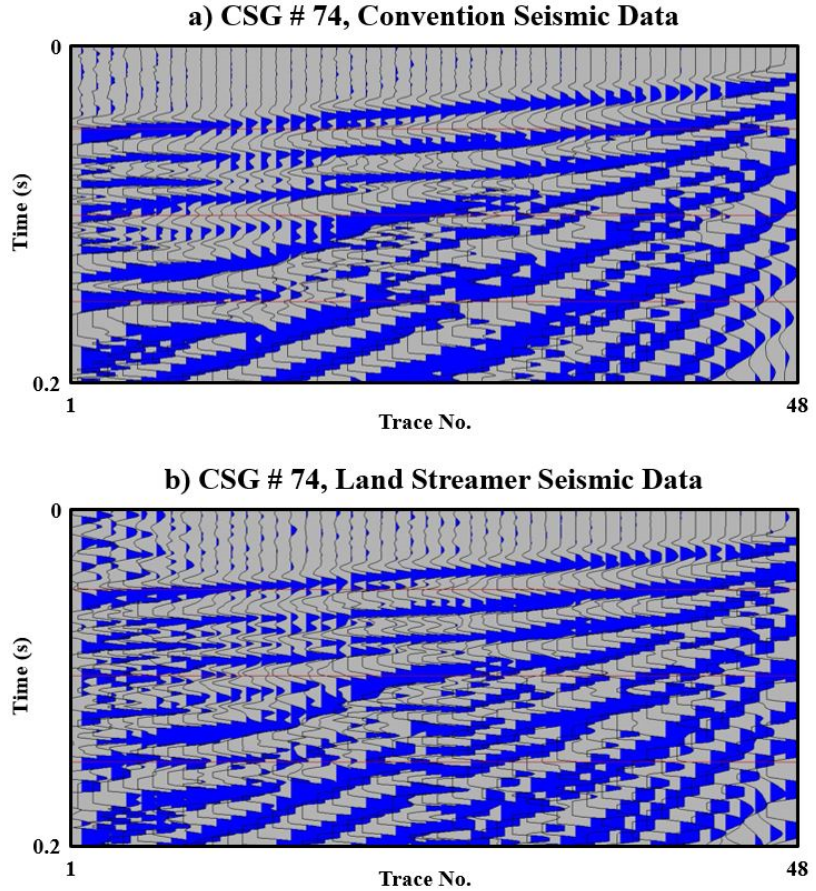
Figure 3. Shot gather no. 74 for both ( a ) conventional and ( b ) land-streamer data